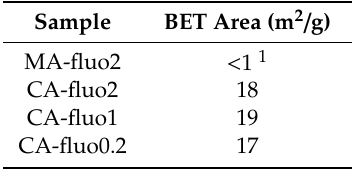
Table 5. Brunauer–Emmett–Teller (BET) specific surface area (m 2 / g) of the synthesised